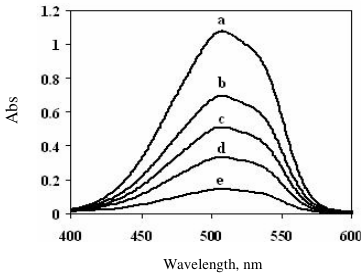
Figure 3 . (a) Blank (without STS) (b) 1.4 µ g mL -1 (c) 1.0 µ g mL -1 (d) 0.6 µ g mL -1 (e) 0.2 µ g mL -1 measured against water